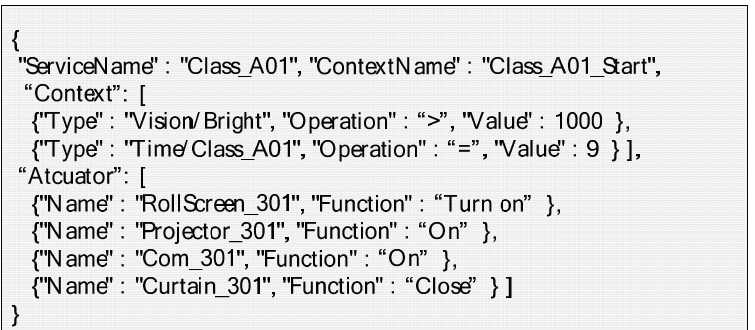
Figure 23. Example of abstracted service